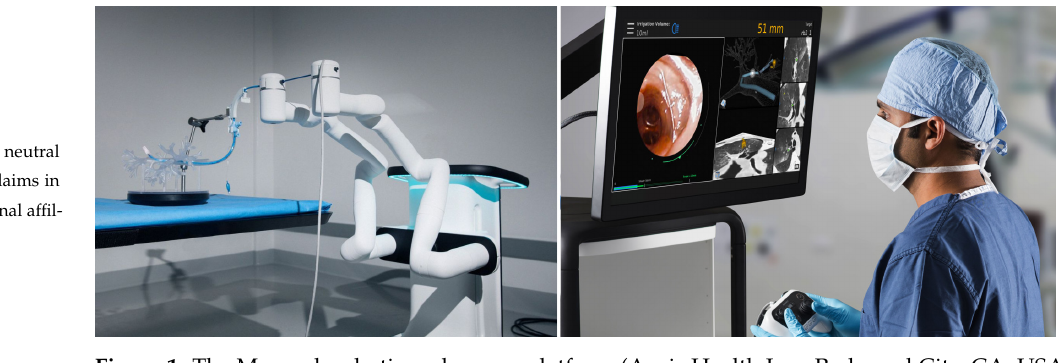
Figure 1. The Monarch robotic endoscopy platform (Auris Health Inc., Redwood City, CA, USA), as an example of image-guided surgery